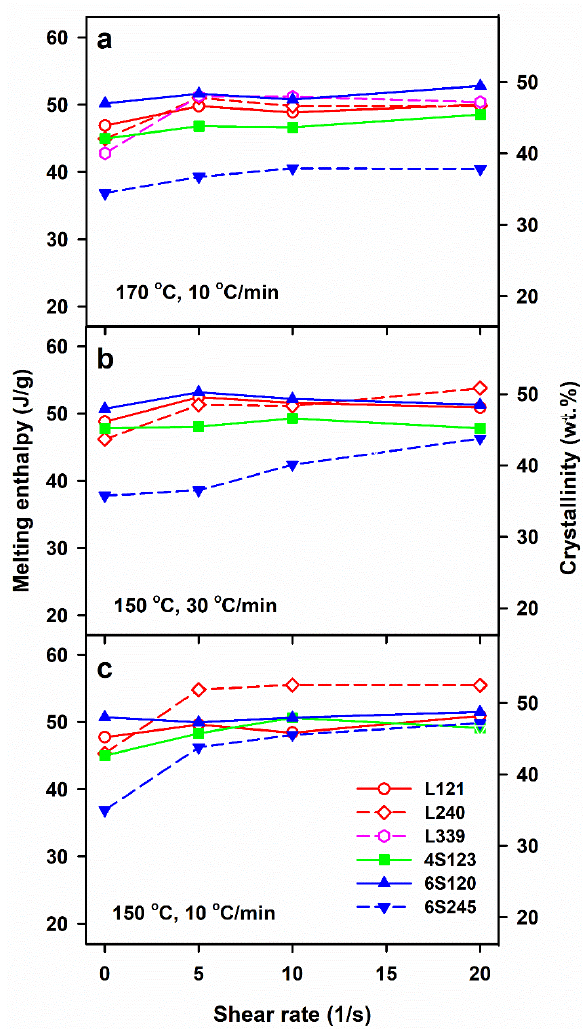
Figure 6. Melting enthalpy, ∆ H m , measured during DSC heating at 5 ◦ C/min of PLLAs previously cooled at 10 and 30 °C/min, after shearing at 170 C ( a ) and 150 °C ( b , c ) versus shear rate, 𝛾̇ .